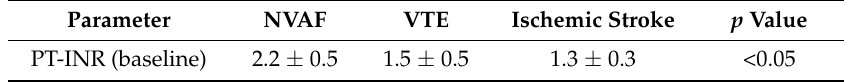
Table 3. Baseline PT-INR in patients classified according to the underlying